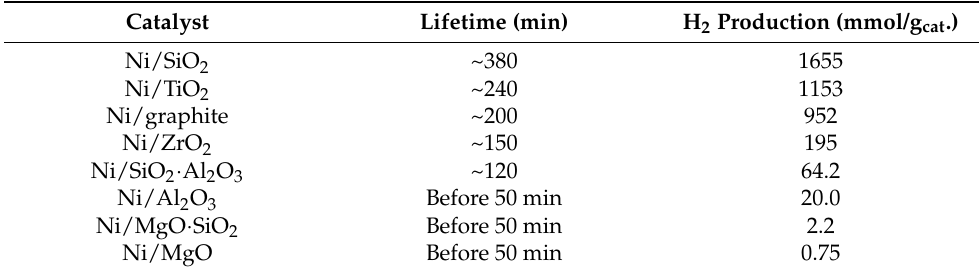
Table 11. Catalytic performance of Ni catalysts prepared via impregnation method and supported on various types of materials at 500 ◦ C and 1 atm